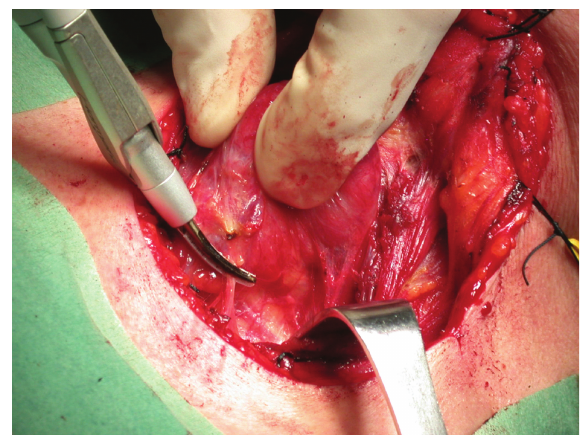
Figure 4: Sealing of inferior thyroid artery with Focus Ultracision Harmonic Scalpel.